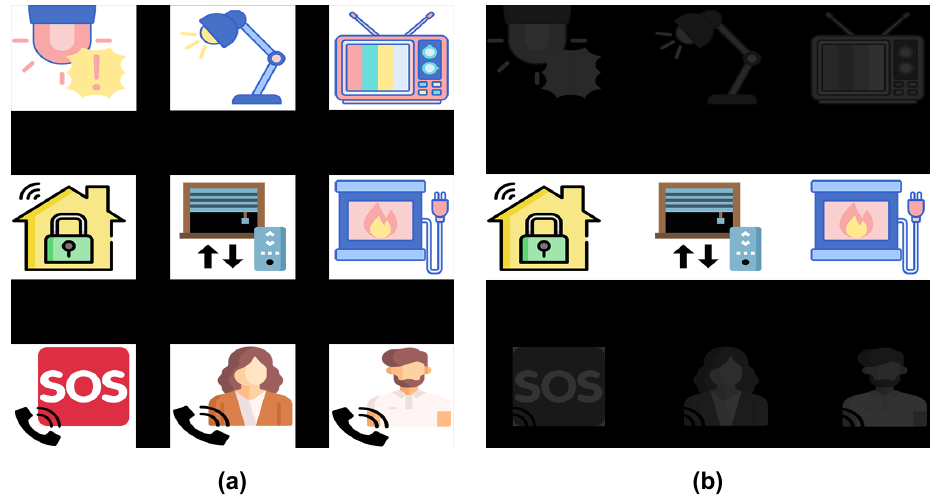
Figure 3. Graphical User Interface (GUI) for the two stimulation paradigms. ( a ) represents the 1-by-1 stimulation paradigm with all the elements intensified, while ( b ) corresponds to the row/column stimulation paradigm only with the second row